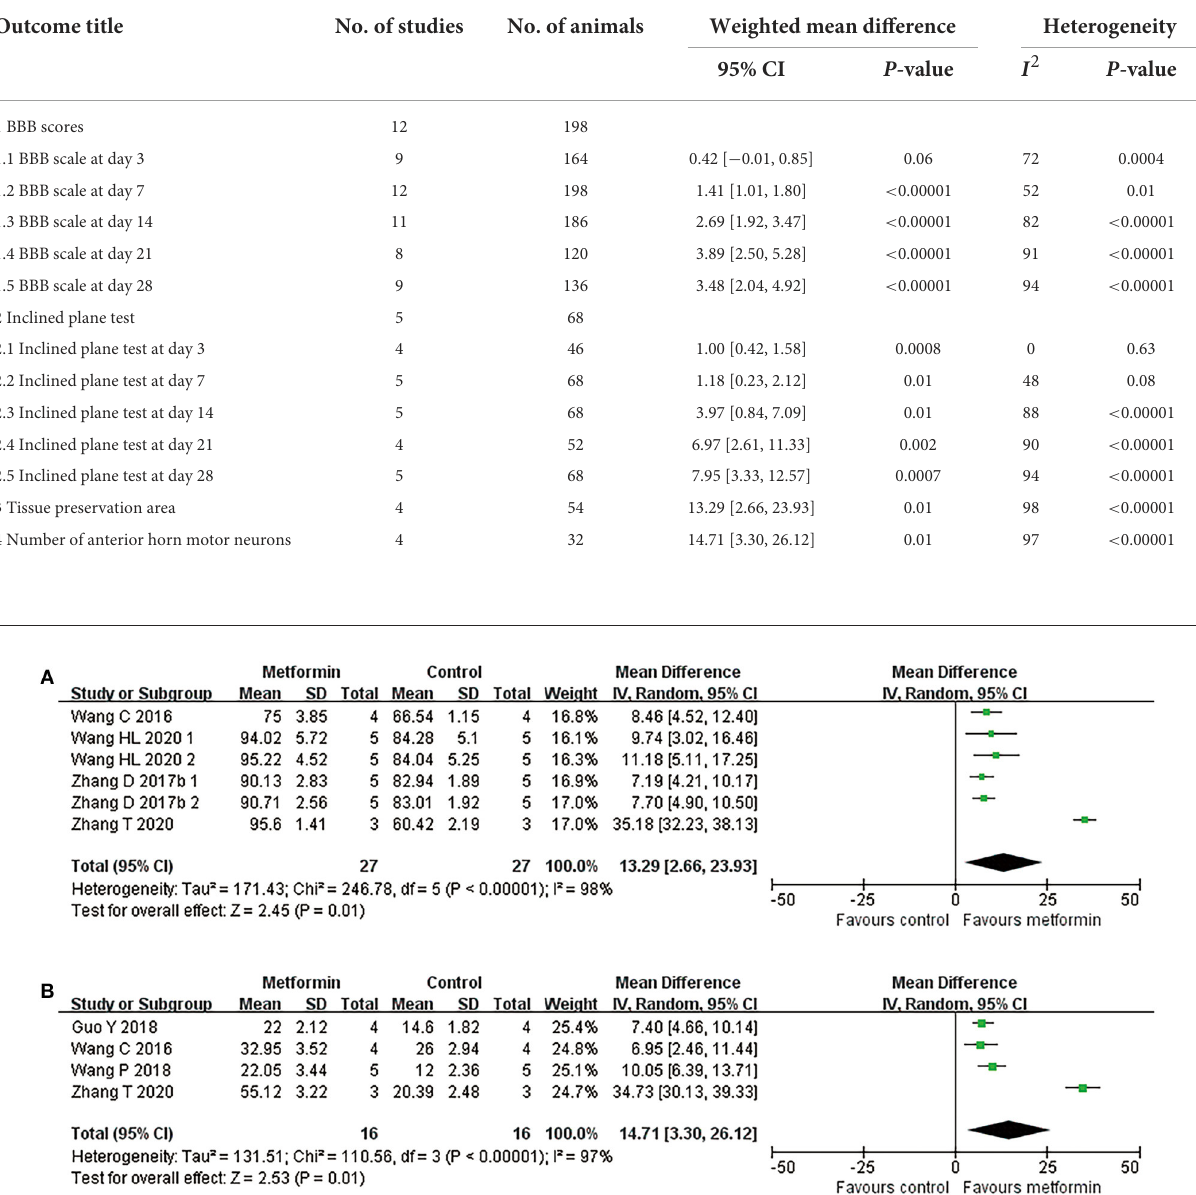
TABLE 4 Summary of overall analyses of the effects of metformin.